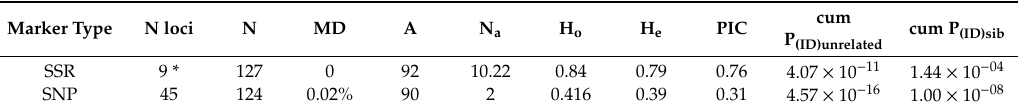
Table 4. Comparison of genetic diversity statistics assessed for SSR and SNP sets recommended for routine